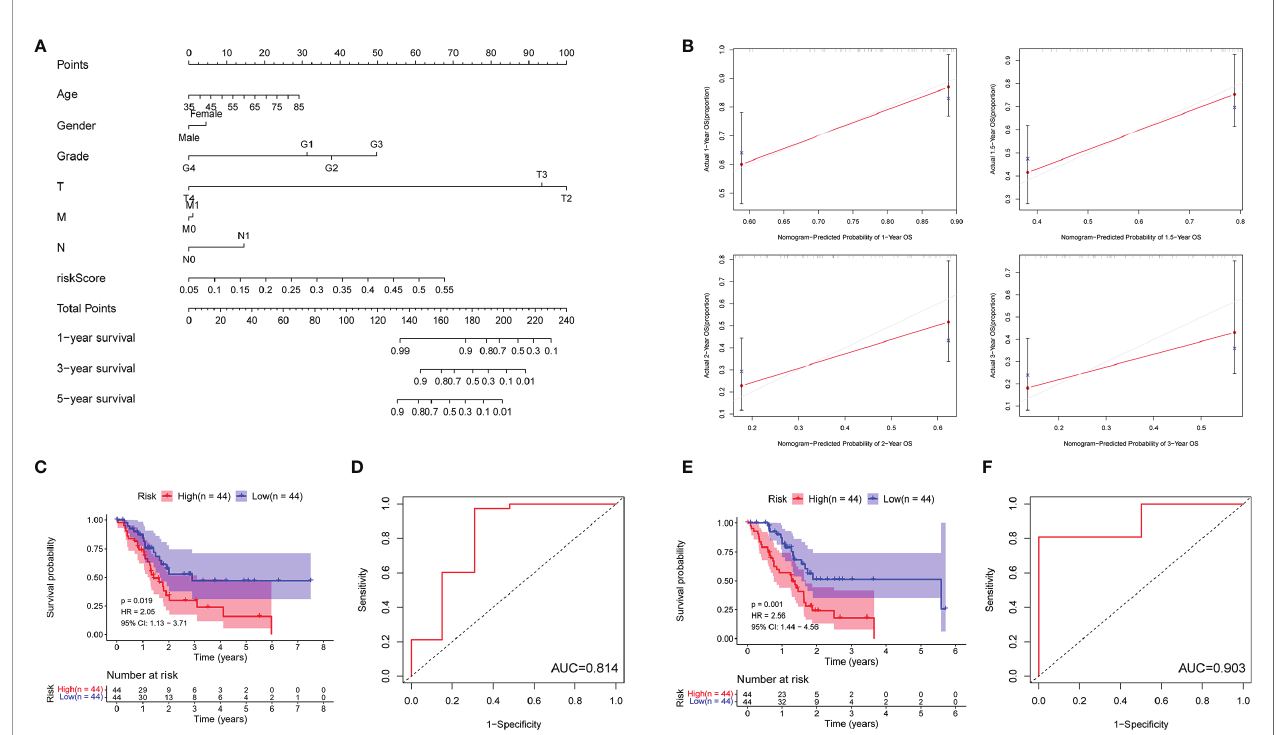
FIGURE 5 | Detecting the prediction value of the m5C-related lncRNA risk model. (A) The prediction of 1-, 3-, and 5-year survival for PDAC patients based on the prognostic nomogram derived from the m5C-related lncRNA risk score and other clinicopathologic feature. (B) Calibration curves illustrated the consistency between predicted and observed 1-, 1.5-, 2-, and 3-year survival rates in PDAC patients depending on the prognostic nomogram. (C – F) Overall survival and ROC analysis in subgroups ( C , D : Group A ; E , F : Group B